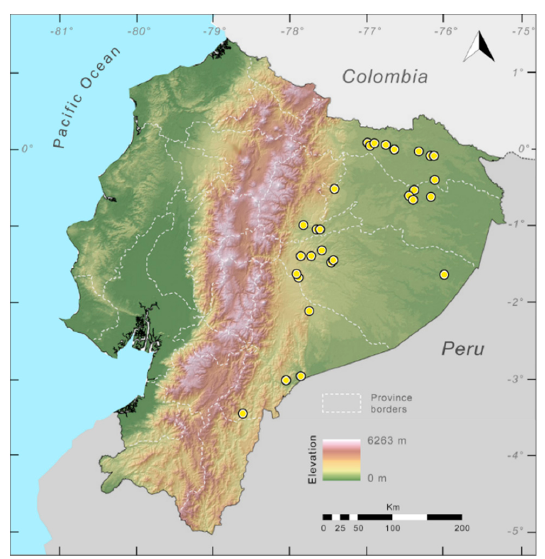
Figure 214. Distribution of Teratohyla midas in Ecuador (yellow dots).